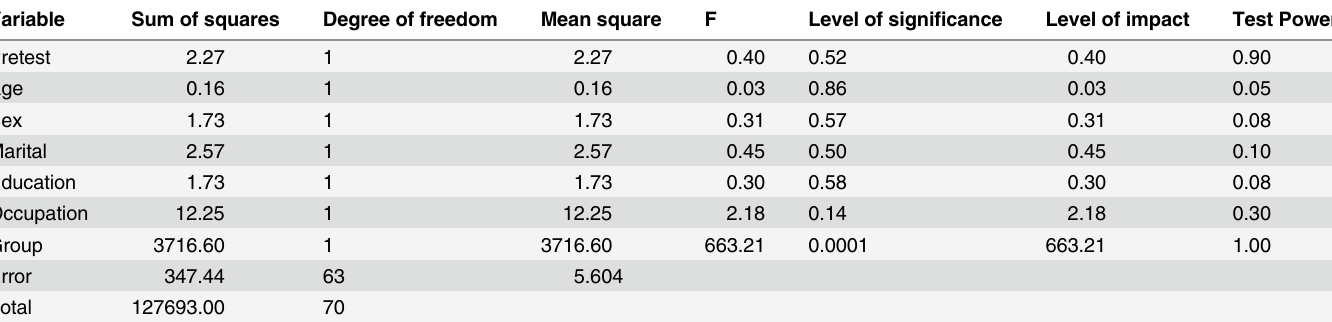
Table 5. The Mean Scores of Pretest and Posttest of Attitude toward Self-Care Behaviors in Study Groups, Based on ANCOVA Results. Variable Sum of